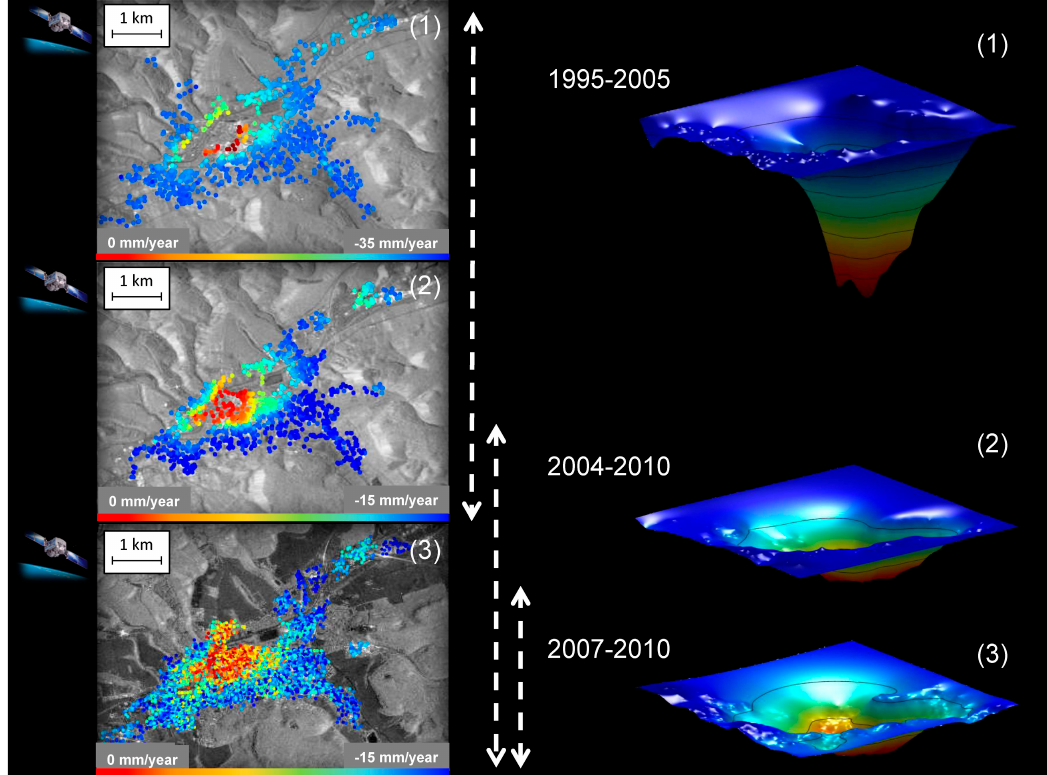
Figure 5. Persistent Scatterer Interferometry PSI reveals subsidence for the city of Sondershausen, Germany. The subsidence rate was delineated based on (1) ERS − 1/ − 2 data from 1995–2005, (2) ASAR data from 2004–2010, and (3) PALSAR data from 2007–2010. In the PSI deformation maps persistent scatterers located in the urban area are depicted in front of a geocoded SAR image. The colour of the persistent scatterer points indicates the rate of vertical displacement in mm/year. Based on the PSI deformation maps (left hand) geometric models of the subsidence were derived (right hand column of figures; modified after Salepci [113].